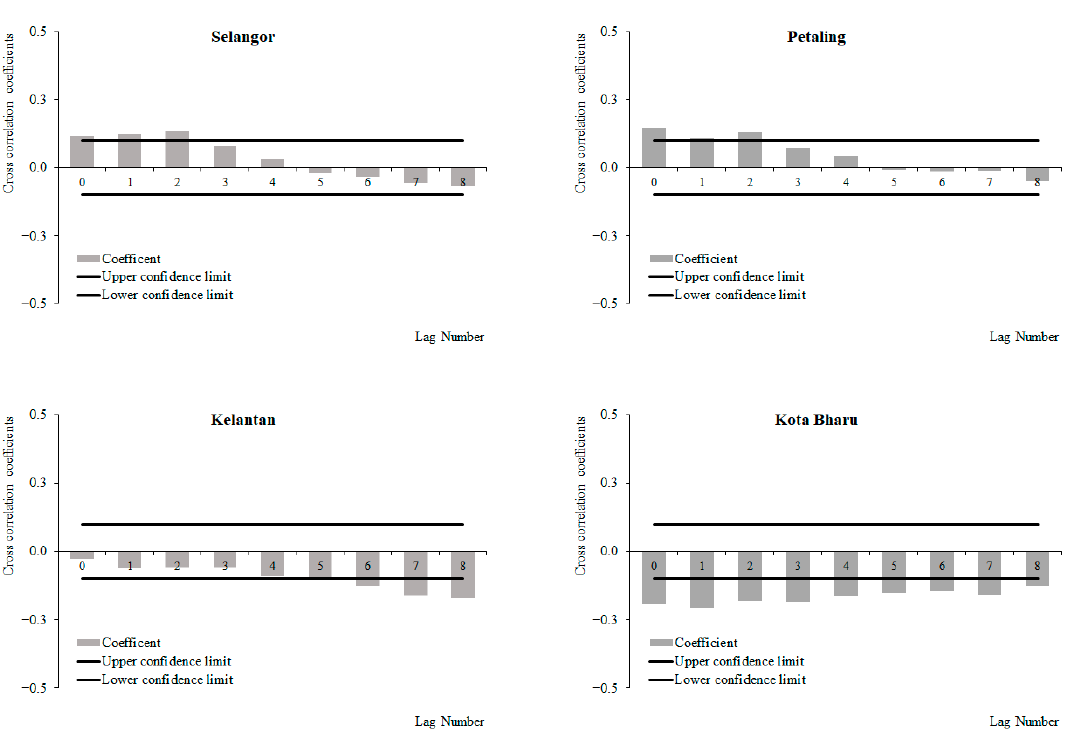
Figure 13. Cross-correlation function between dengue cases and wind speed in Selangor, Petaling, Kelantan and Kota Baharu, 2015 to 2019.